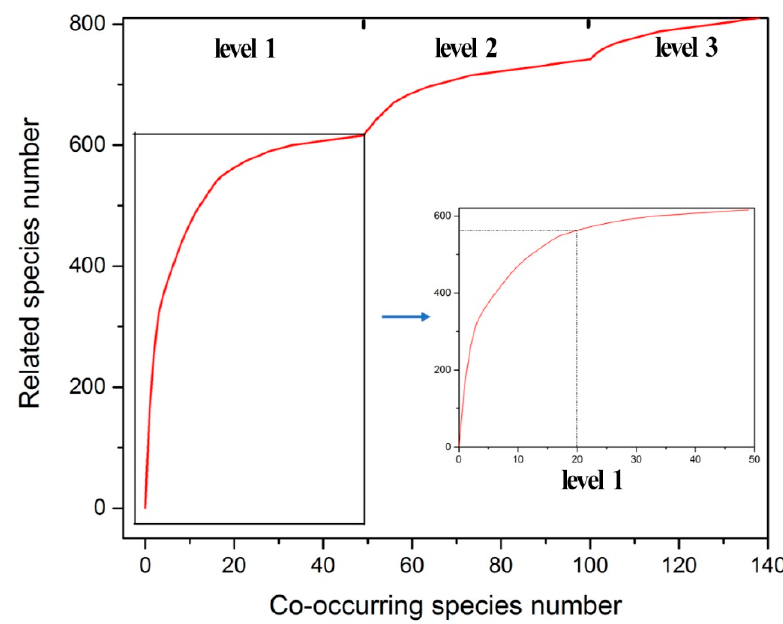
Figure 6. Correlation curve of the co-occurring species.